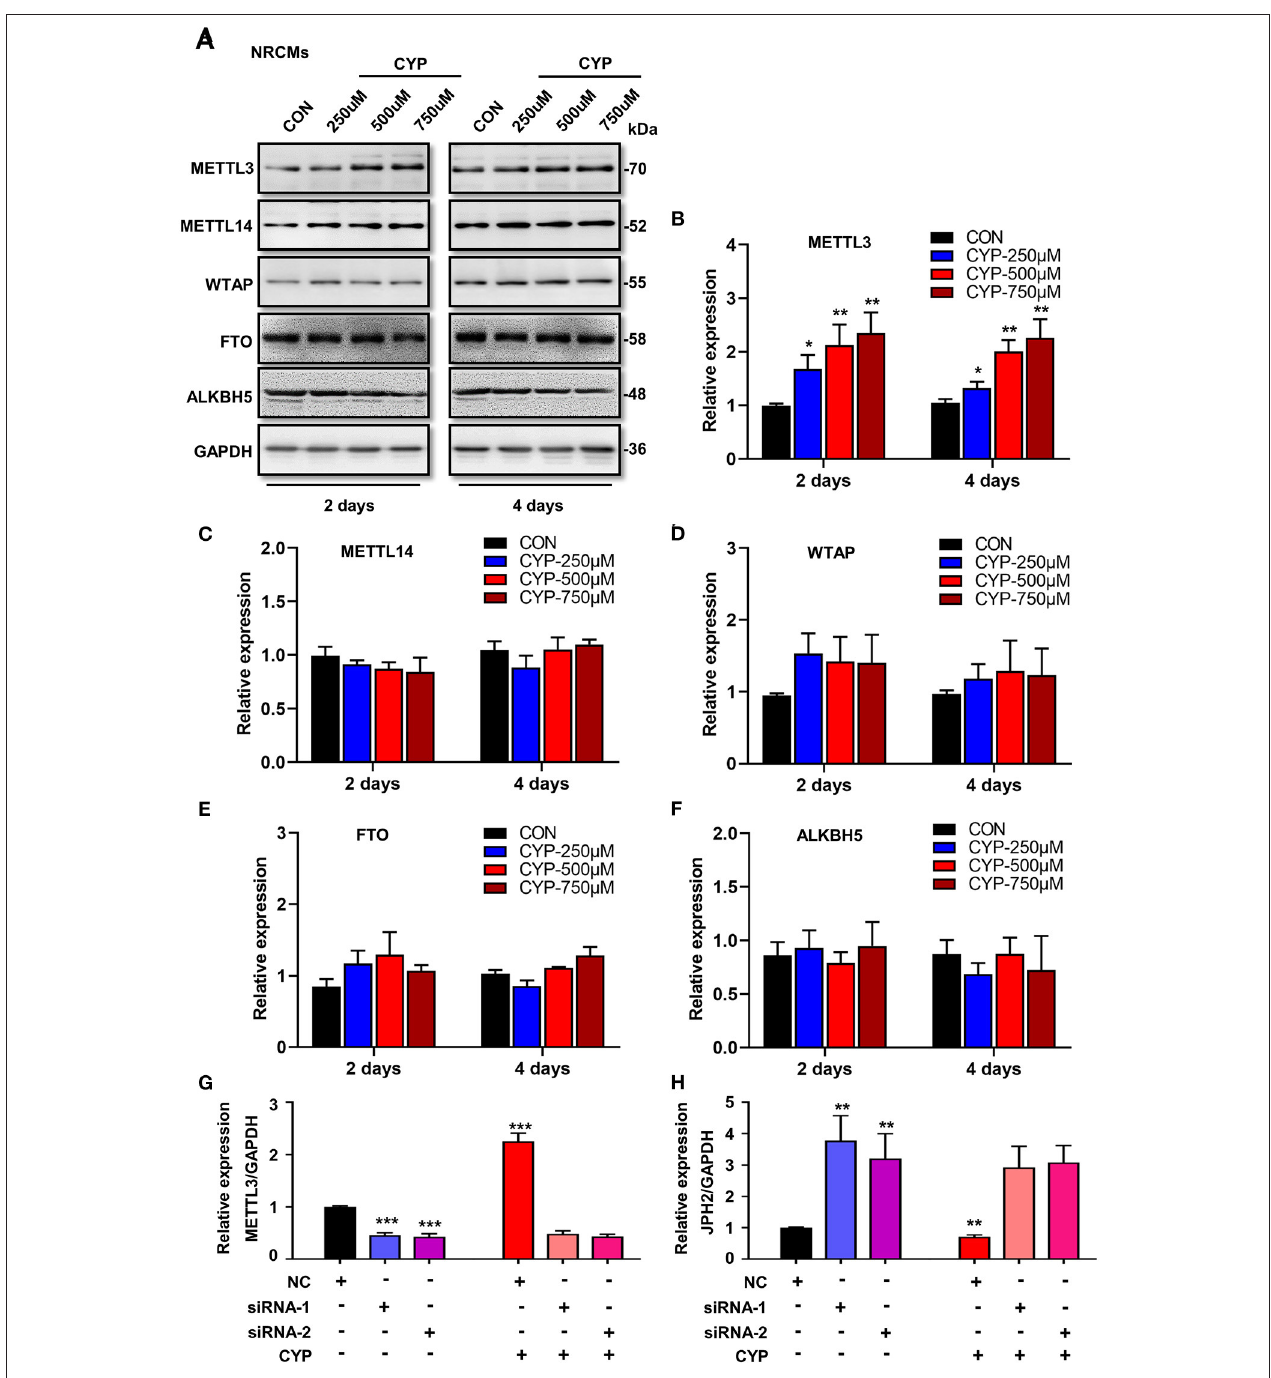
FIGURE 6 | CYP induced the downregulation of JPH2 expression through upregulating METTL3 expression. (A) Western blot analyses of METTL3, METTL14, WTAP, FTO and ALKBH5 expression in NRCMs with or without CYP for 2 or 4 days. Quantitative analysis of protein levels of METTL3 (B) , METTL14 (C) , WTAP (D) , FTO (E) , and ALKBH5 (F) in NRCMs treated with CYP for 2 or 4 days. The data are shown as the mean ± SE of three experiments. * P < 0.05, ** P < 0.01 vs. CON. Real-time PCR analysis of METTL3 (G) and JPH2 (H) expression in NRCMs transfected with si-METTL3, or NC sequences with/without CYP. CYP did not decrease the expression of JPH2 in METTL3-deficient NRCMs. The data are shown as the mean ± SE of three experiments. ** P < 0.01; *** P < 0.001 vs. negative control (NC).